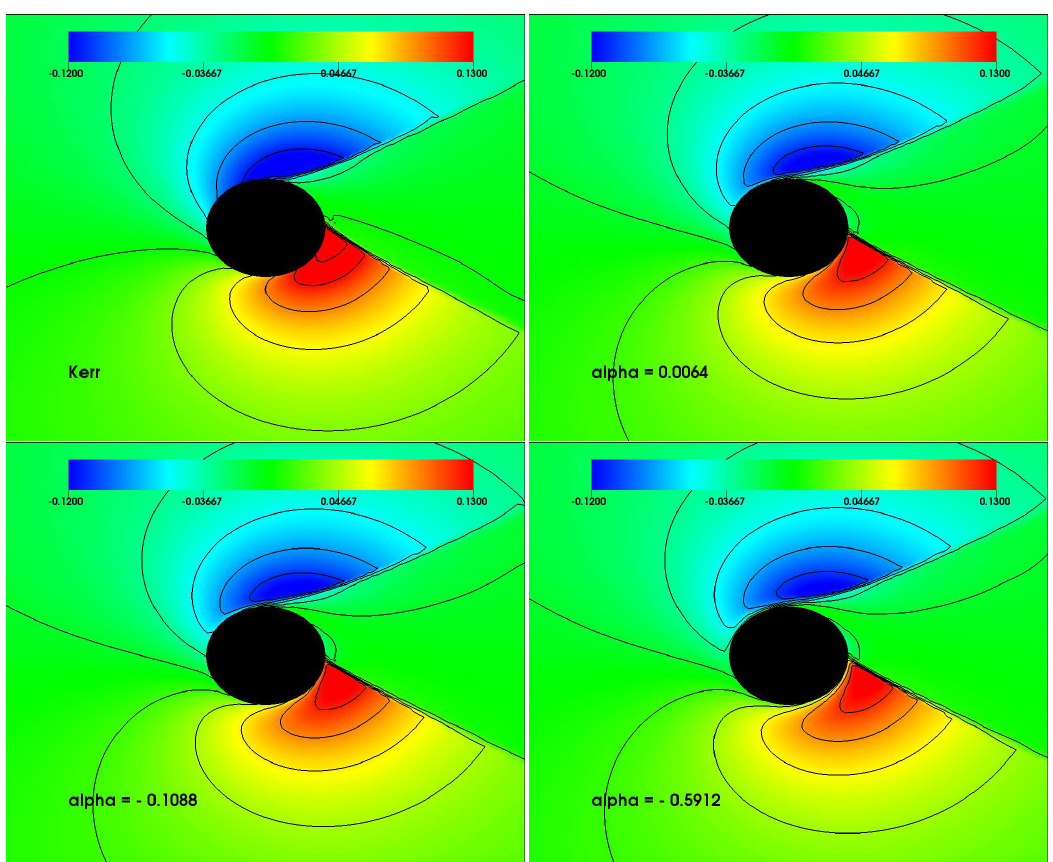
= 0 . 2 on the equatorial plane ( r φ ) a long time later after the Figure 8. The radial velocity profiles for Kerr and EGB black holes with V Figure 8. The radial velocity profiles for Kerr and EGB black holes with V ∞ = 0.2 on the equatorial − ∞ disk reached the steady state. φ ) a long time later after the disk reached the plane ( r −